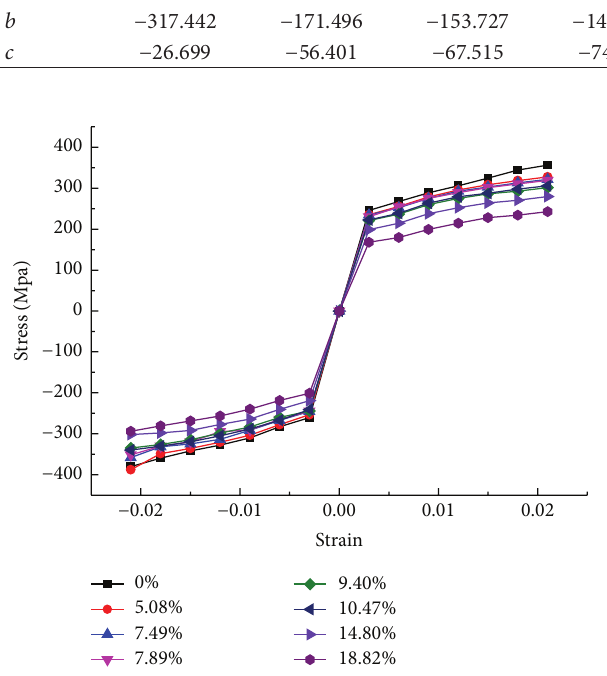
Figure 5: Hysteresis curve on varying degrees of corrosion steel.